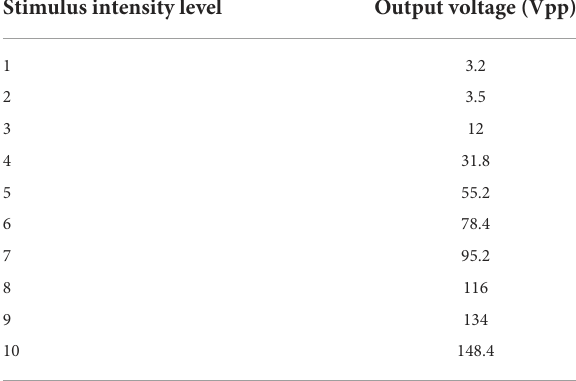
TABLE 1 Output voltage and duration values for each intensity level of electrical stimulus. Stimulus intensity